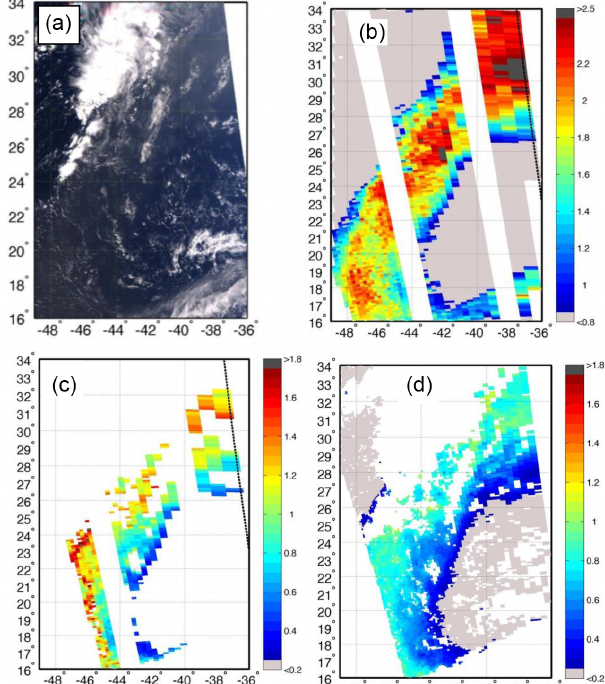
Figure 4. (a) RGB image for MODIS on 11 October 2008 (16:30UTC) over the N. Central Atlantic. (b) Absorbing Aerosol Index (c) OMI operational AOD 388nm (d) MODIS AOD 500nm. The dashed line is the east edge of the OMI orbit. Pixels with no retrieval are colored white. Pixels in gray are those below the re- spective color bar